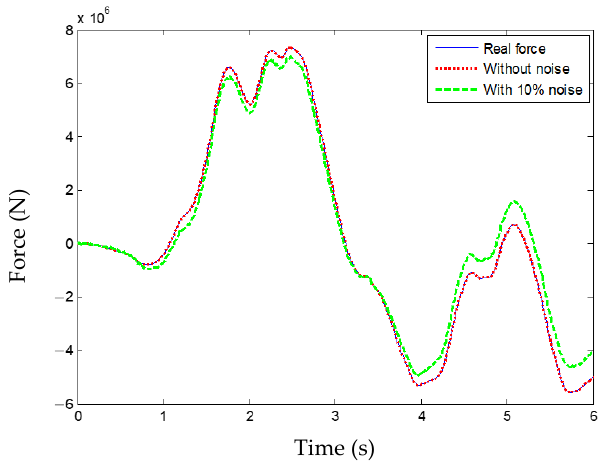
Figure 8. Force identification result (scenarios 3 and 4).